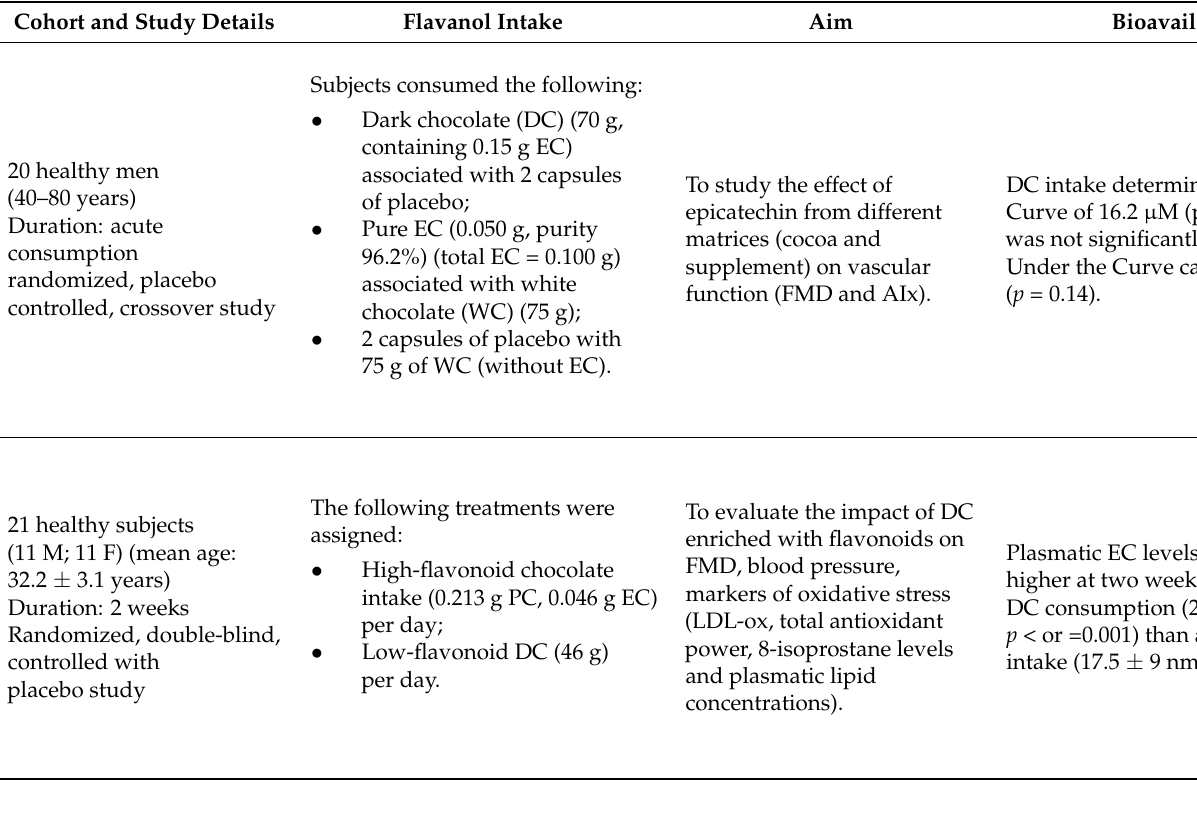
Table 2. Flavanols’ beneficial effects and bioavailability in human